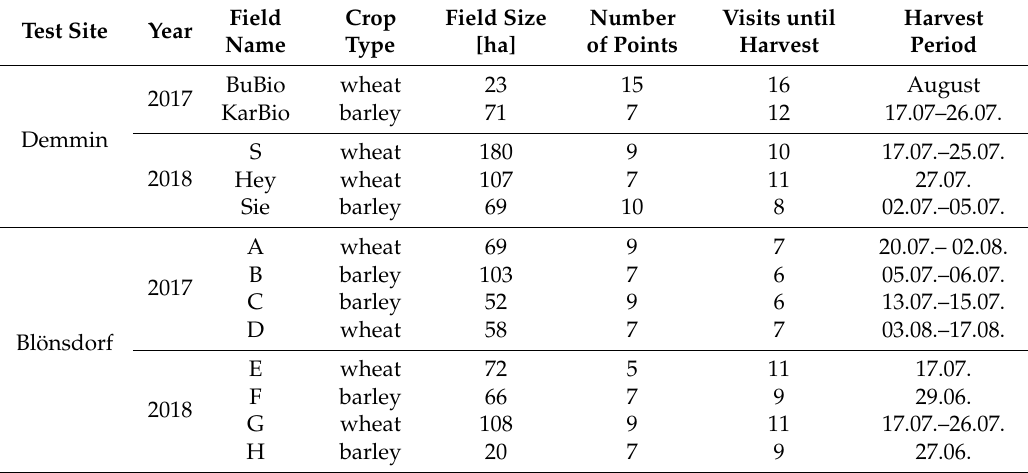
Table 1. Observed fields in Demmin and Blönsdorf 2017 and